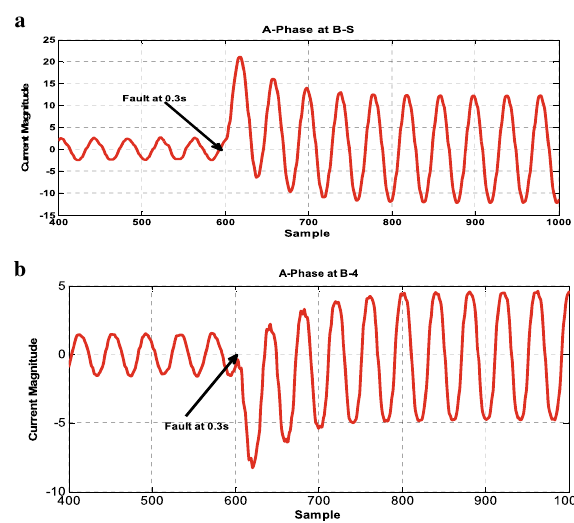
identified by simulation of different Th value and the oc- currence of faults taken simultaneously and the fault case/ no fault cases are analyzed. The threshold ( Th = ±45 ) is se- lected for this test system (+ve sign, for fault is located within 50% distance from B-S) and ( − ve sign, for fault is located 50% distance from B-4). The Th value is selected after a large number of simulations conducted.